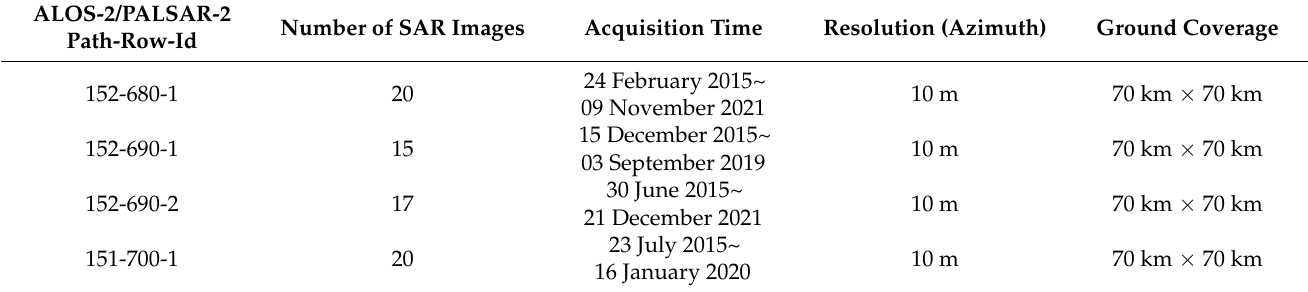
Table 2. ALOS-2/PALSAR-2 Data.